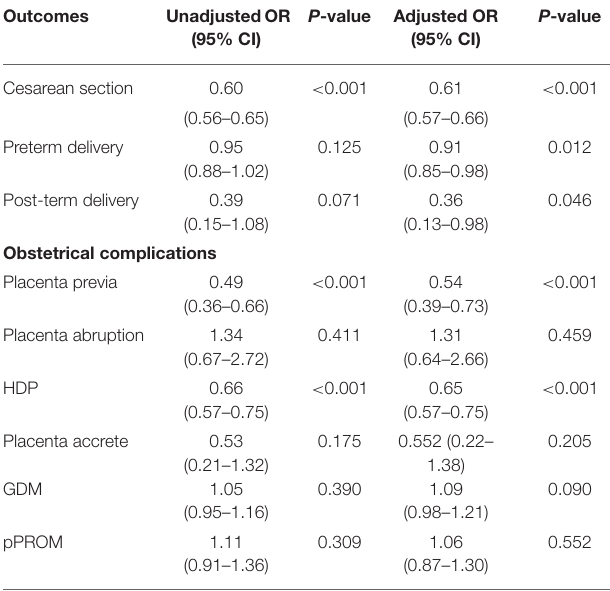
TABLE 3 | Logistic regression of obstetrical outcomes of OS-FET vs. HRT-FET.